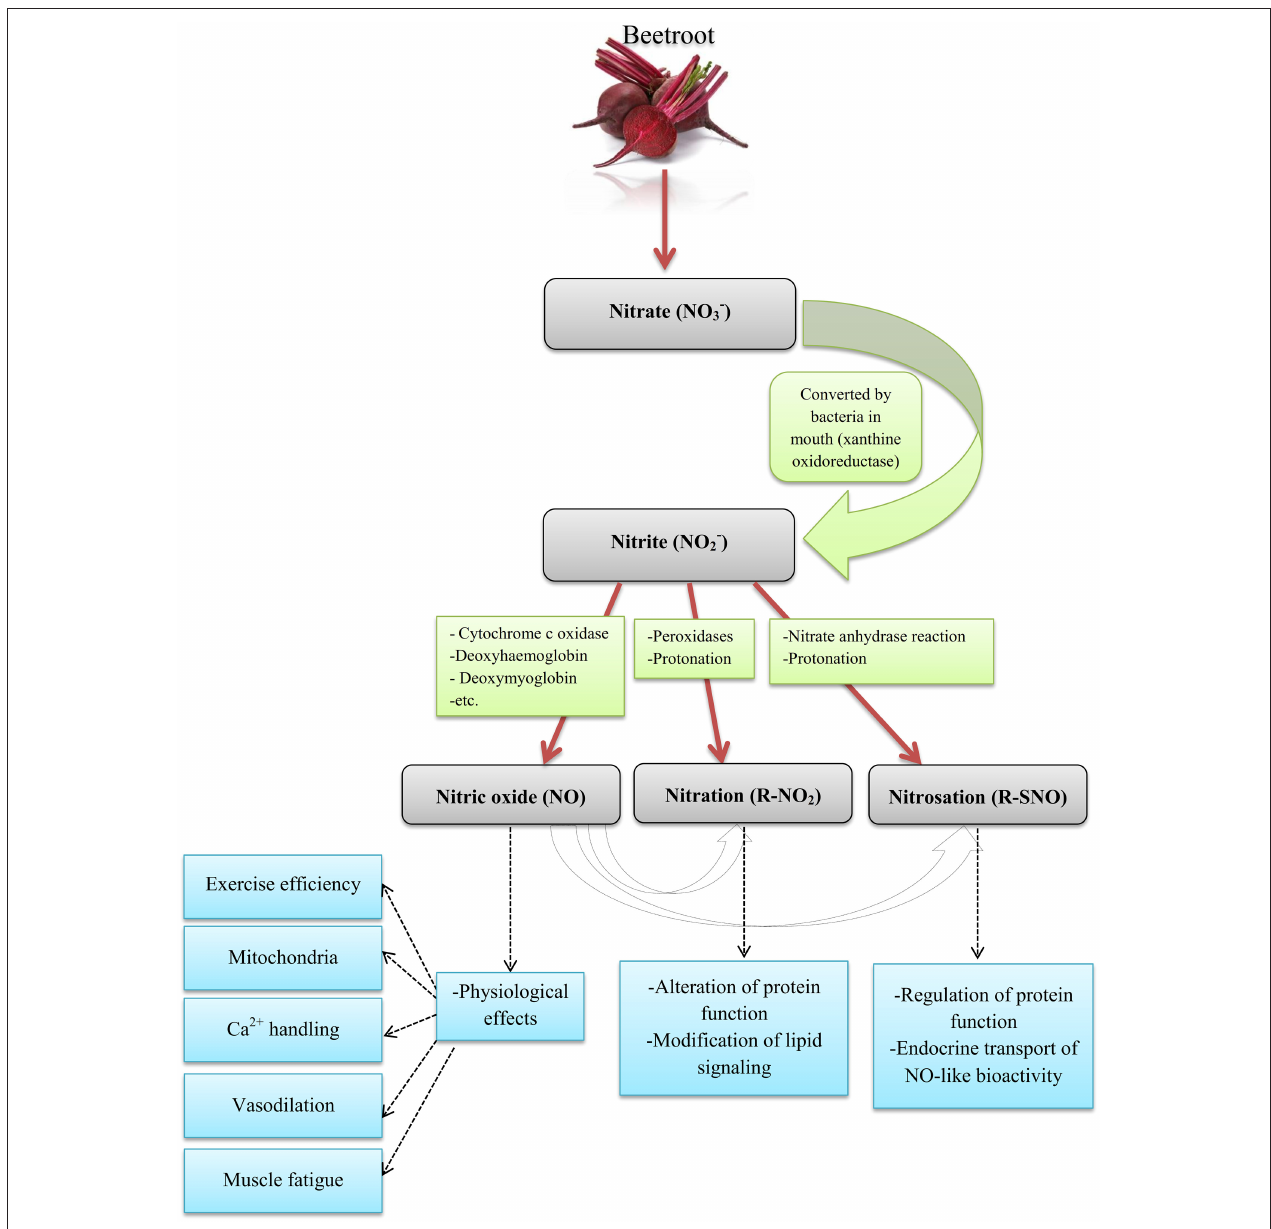
FIGURE 1 | The pathways of NO production from Beetroot in humans. Source: Ormsbee et al. (1); Lundberg et al. (10); Weitzberg and Lundberg